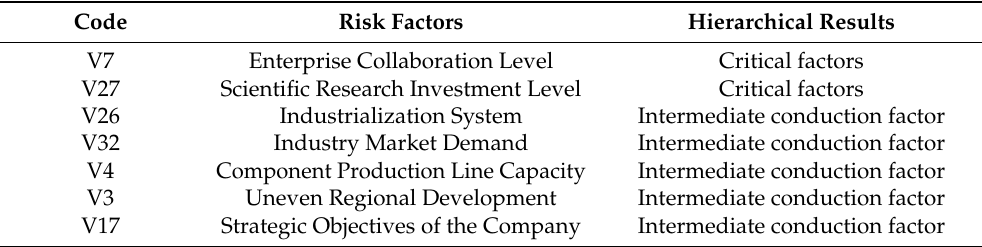
Table 10. Hierarchical analysis of risk factors.